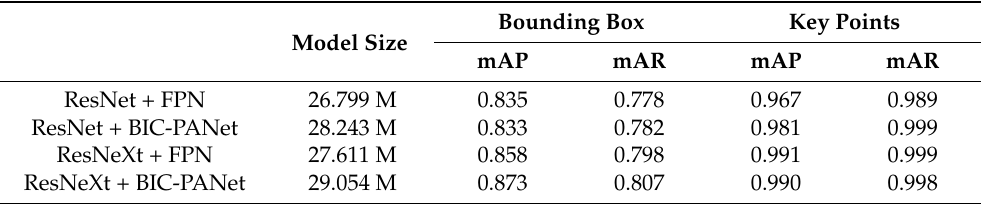
Table 6. Model performance with different combinations of backbone network and FPN. Bounding Model Size